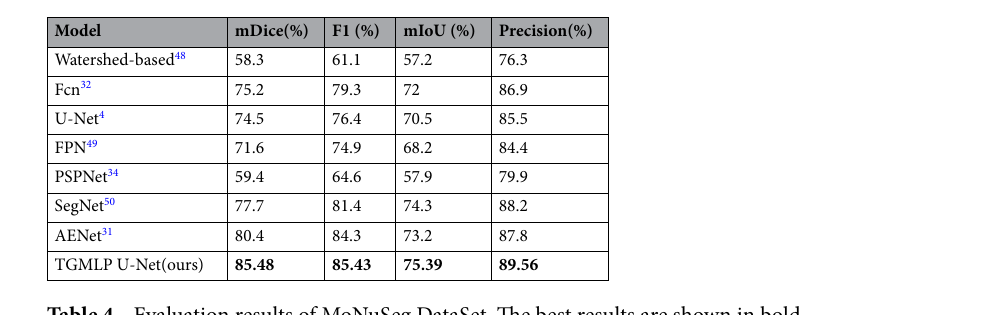
Table 4. Evaluation results of MoNuSeg DataSet. The best results are shown in bold.